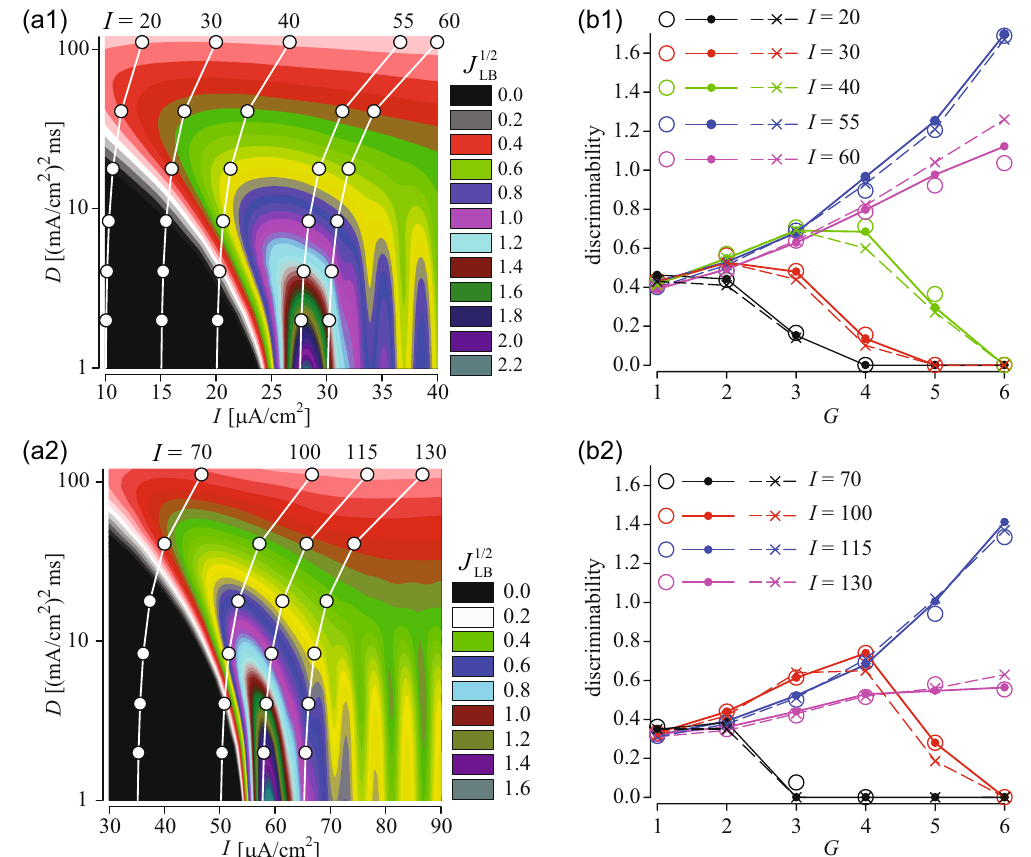
Figure 7. Signal detection by a single node and by tree networks. ( a ): Square root of the lower bound of the Fisher information (9) of the single HH (a1) and single FH (a2) node versus input current and noise intensity. Superimposed white lines with circle symbols show the scaling of the effective input current, Eq. (24), and effective noise intensity, Eq. (25), for tree networks with branching ratio d = 2 and increasing number of generations. Each of these lines corresponds to values of the external current to peripheral nodes, I , indicated at the top of panels ( a ). The number of generations, G , increases from 1 (top) to 6 (bottom). Noise intensity for tree networks is D = 500 [( μ A/cm 2 ) 2 ms]. ( b ): Discriminability (8) versus the number of generations, G , for tree networks with branching ratio d = 2 and indicated values of the input current I for HH (b1) and FH (b2) nodes. The increment of the input current is Δ I = 2 μ A/cm 2 and noise intensity is D = 500 [( μ A/cm 2 ) 2 ms]. Open circles refer to results from numerical simulations of corresponding tree networks. Solid lines with filled circles show the theoretical scaling predictions obtained from numerical calculations of the discriminability of a single HH or FH node with input current and noise intensity scaled according to Eqs (24) and (25), respectively. Dashed lines with symbols × show the theoretical predictions of discriminability obtained from the lower bound of the Fisher information of panels (a1, a2) using relation (10) with the input current increment scaled according to Eq. (24). In all panels the spike count statistics was calculated for T = 200 ms windows. The coupling strength on the panels (b1, b2) is κ = 1000 mS/cm 2